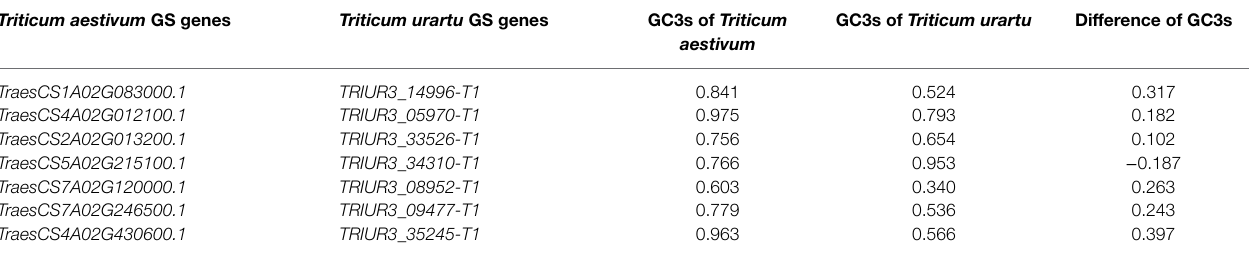
TABLE 1 | The GC3s variation of grain size genes during polyploidization with Triticum aestivum and Triticum urartu . Triticum aestivum GS genes